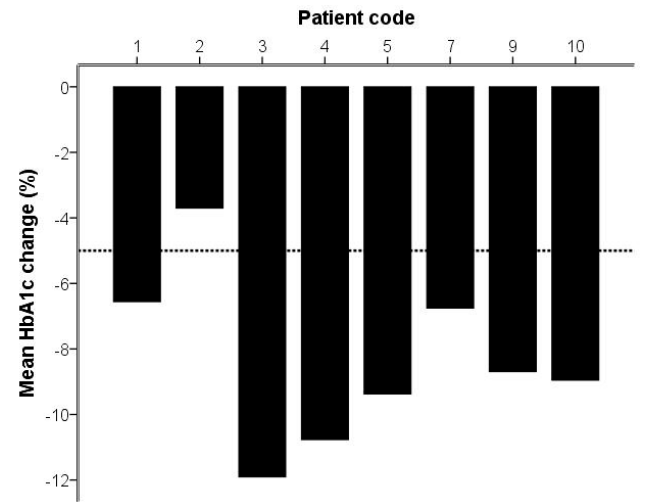
Figure 2. Bar chart diagram illustrating changes in HbA1c for all the participating individuals after two weeks with the Okinawan-based Nordic diet.